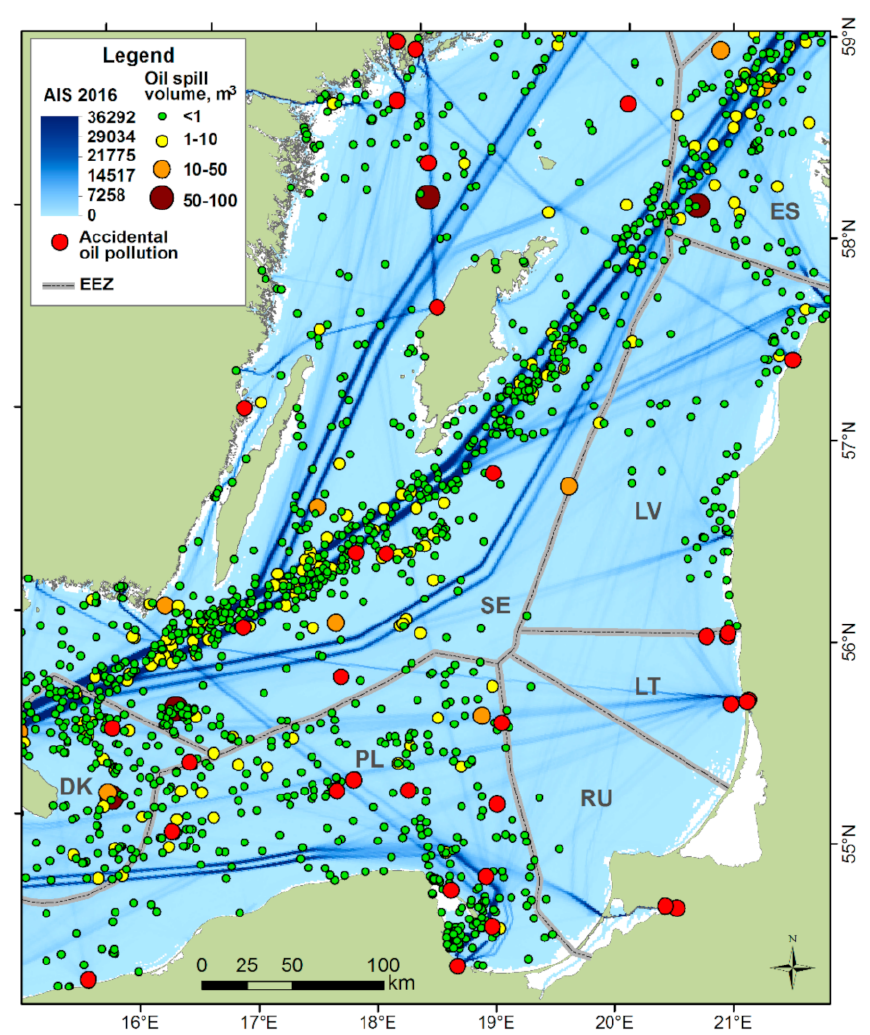
Figure 1. Monthly average traffic density of the HELCOM AIS signals for 2016, volume of illegal oil discharges observed during aerial surveillance flights by HELCOM Contracting Parties during 1998–2017, and accidental oil pollution observed during the period from 1989 to 2017 (Courtesy: E.V. Krek based on statistical data published by